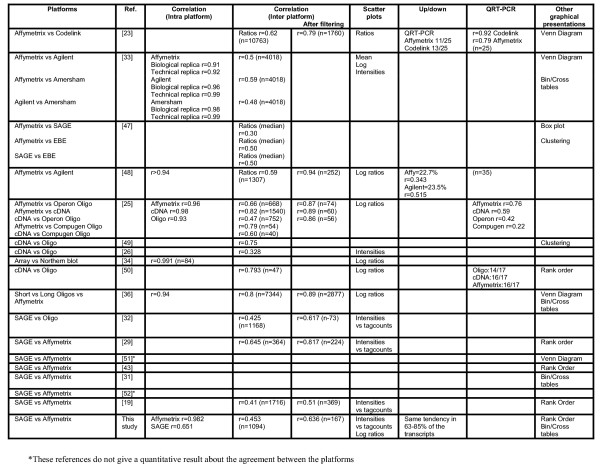
Literature overview of platform comparisons